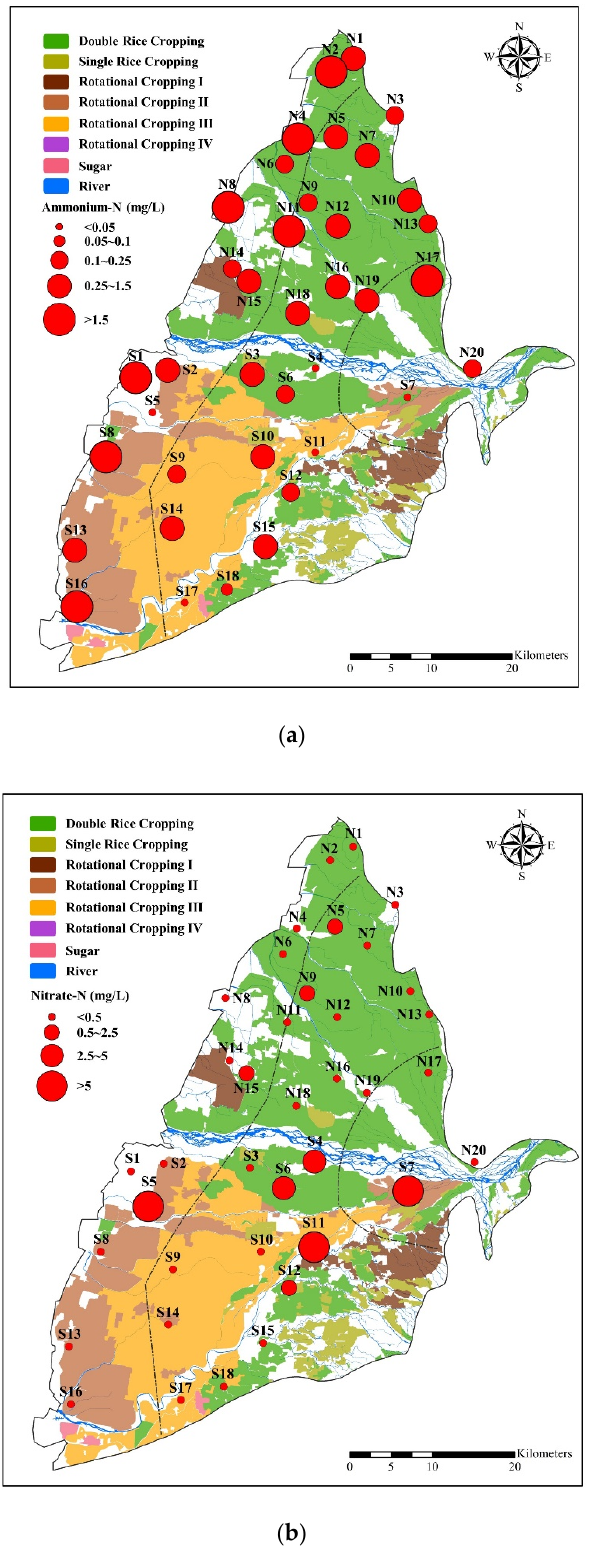
Figure 4. Spatial distribution of ( a ) ammonium–N and ( b ) nitrate–N in different concentration ranges in all observation wells under various cropping